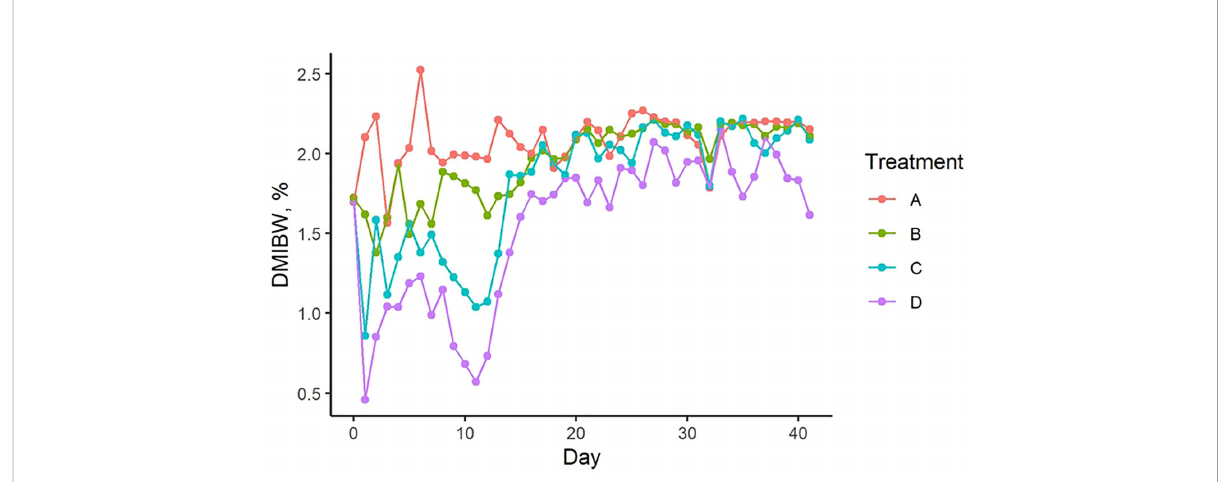
FIGURE 2 Change in pellet dry matter intake as a percent of body weight over time from experimental day 0 to day 41 (corresponding to day 210 to day 251 of gestation, respectively). Treatment A contained 0.00% tea saponin (TS), B contained 0.16% TS, C contained 0.32% TS, and D contained 0.64% TS.